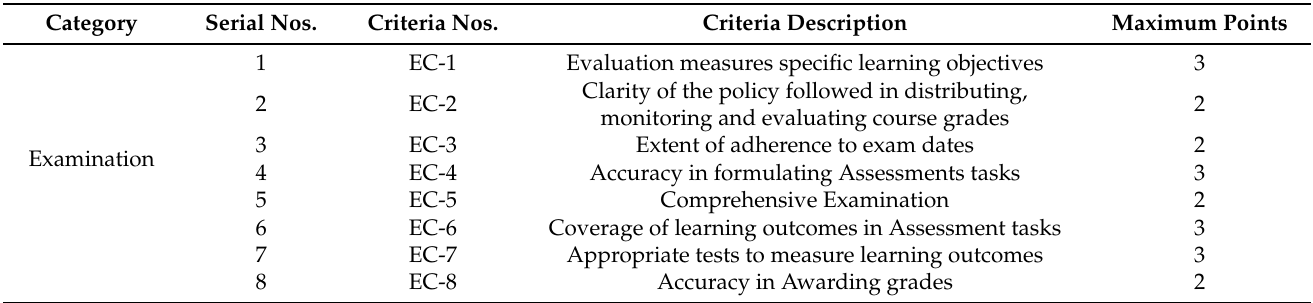
Table 4. QTEF—examination